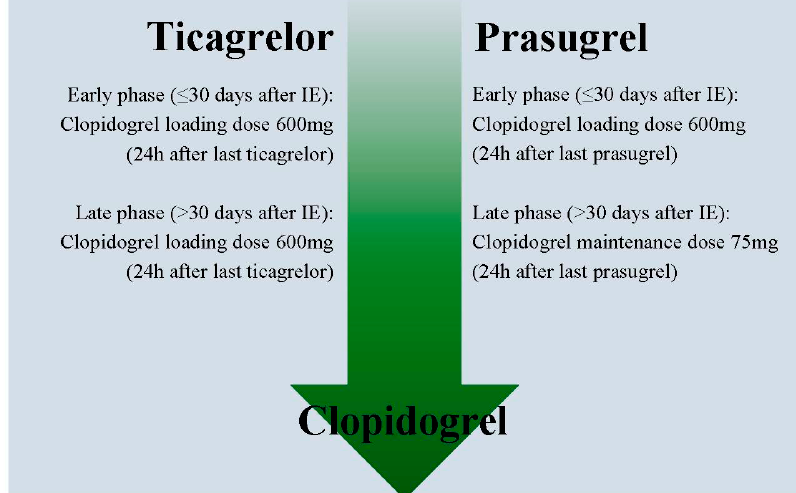
Figure 2. Recommended clopidogrel doses when de-escalating. When de-escalating from ticagrelor or prasugrel to clopidogrel in the early phase ( ≤ 30 days after the index event), a loading dose of 600mg should be administered 24 h after the last dose of the potent P2Y 12 inhibitor. In the late phase (>30 days after the index event), a loading dose of 600 mg should only be administered from ticagrelor to clopidogrel, while a maintenance dose of 75 mg should be administered when de-escalating from prasugrel to clopidogrel. If de-escalating due to bleeding or bleeding concerns, a 75 mg clopidogrel dose could be considered instead of a loading dose irrespective of the phase or initial P2Y 12 inhibitor.